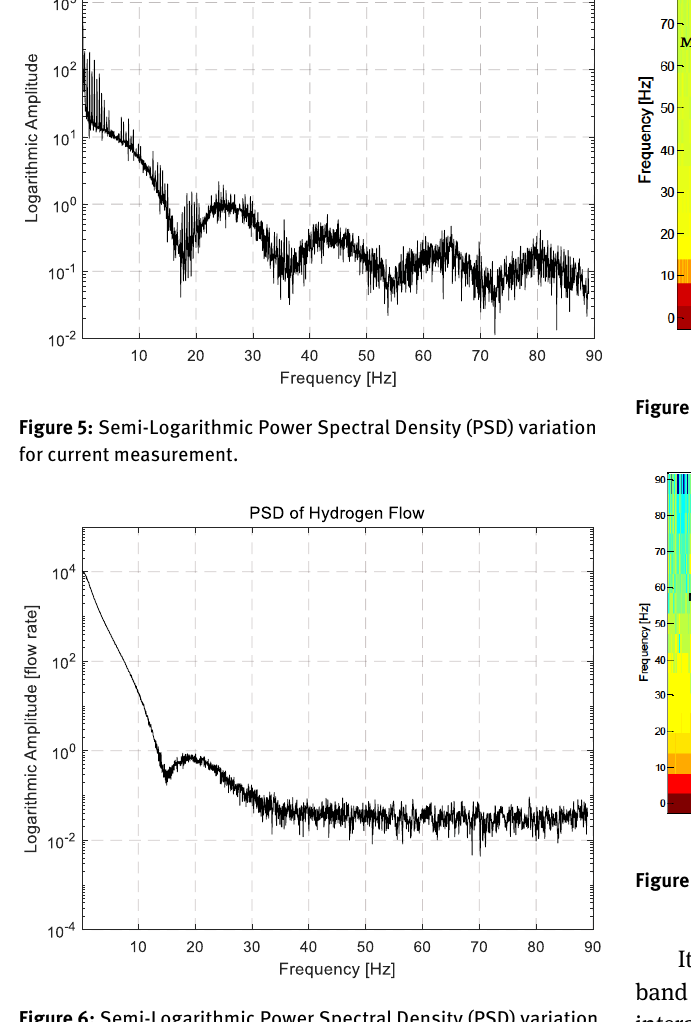
Figure 6: Semi-Logarithmic Power Spectral Density (PSD) variation for hydrogen flow measurement.